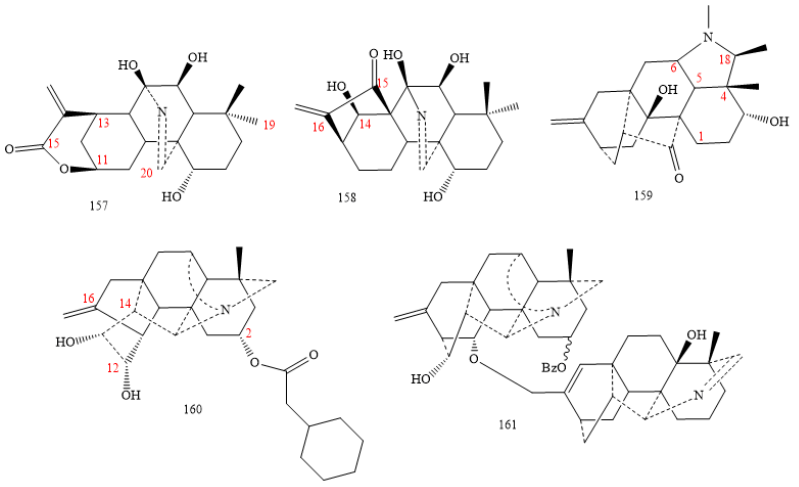
Figure 20. C 20 -rearranged DAs.